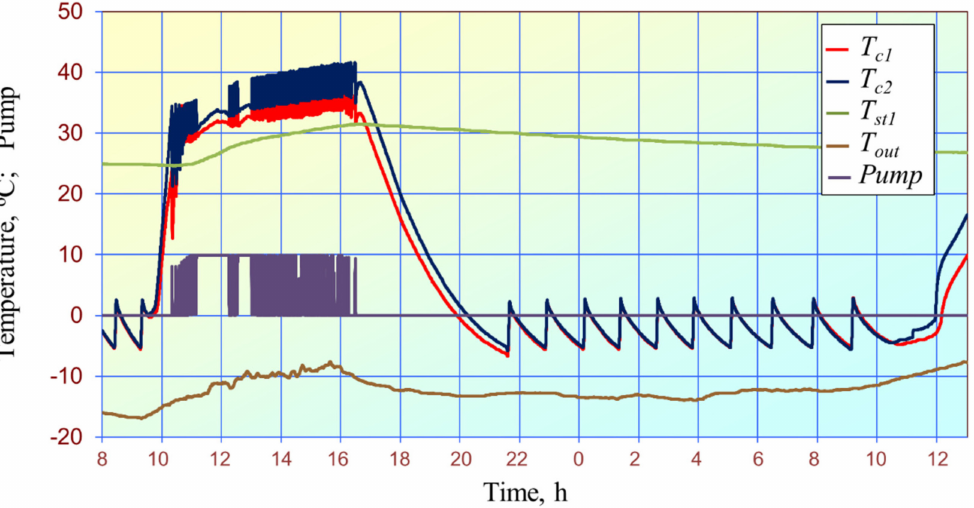
Figure 19. Nighttime control for the solenoid valve (17–18 November